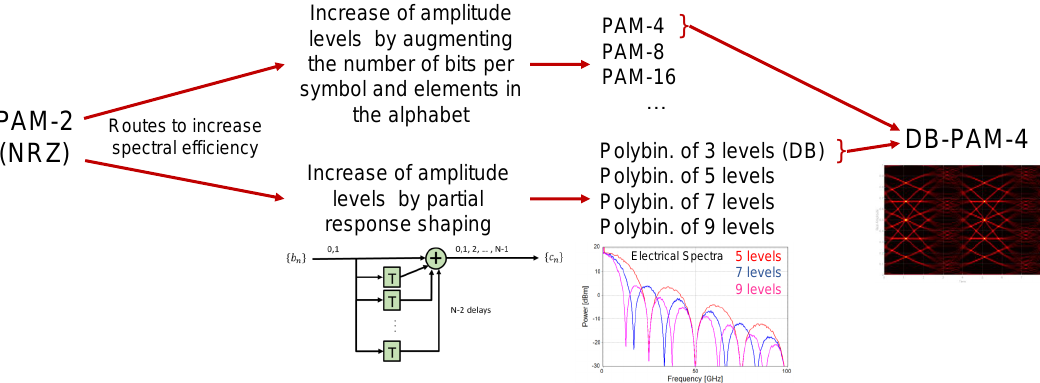
Figure 2. Diagram of two paths that can be followed to increase spectral efficiency in IM/DD systems. Their combination results in DB-PAM-4 modulation and, eventually, polybinary PAM-M